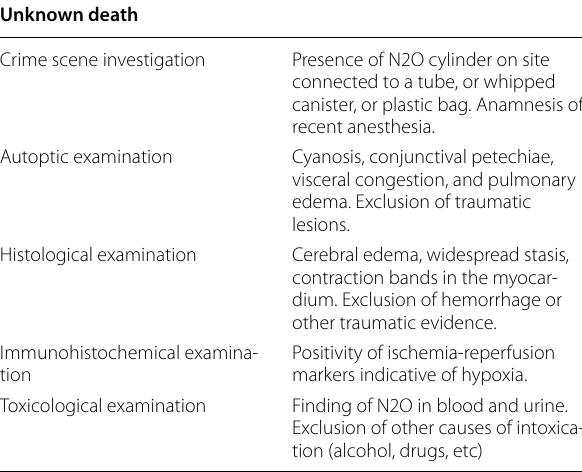
Table 2 Summarized the evidence found in cases of N2O